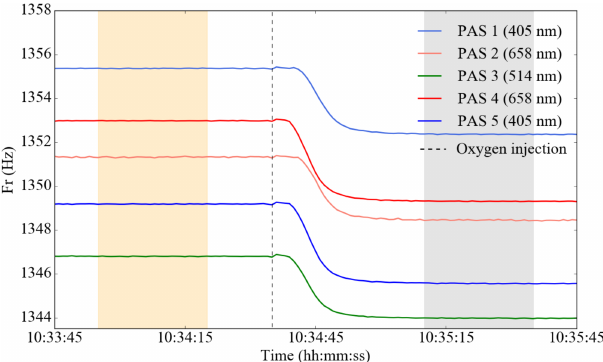
Figure 2. PAS cell resonant frequency as a function of time. Oxygen was introduced into the filtered-air flow at 10:34:35 (dotted line). Mean cell resonant frequencies before (orange highlighted region) and after (grey highlighted region) introducing oxygen were com- puted during the highlighted